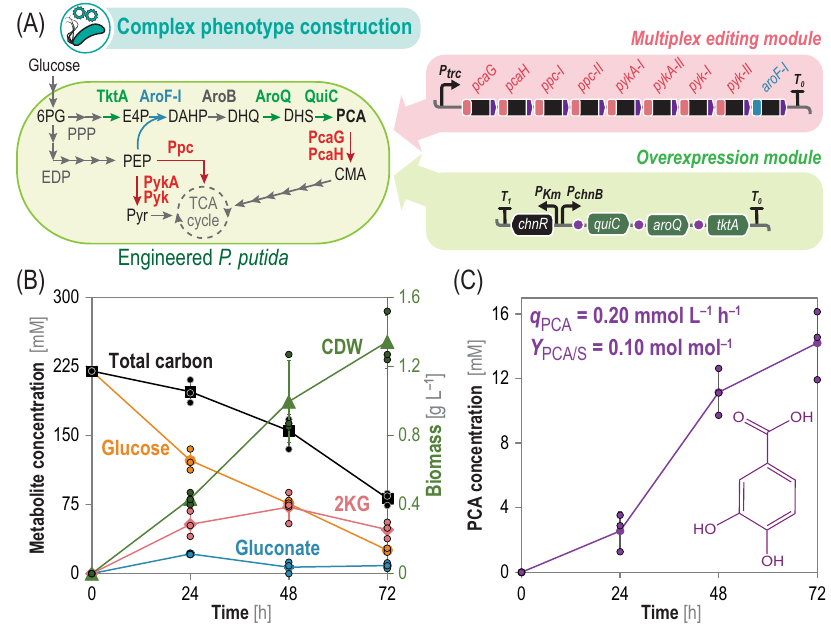
Fig. 5 One-step engineering of P . putida for glucose-dependent production of PCA. A Simpli fi ed metabolic map indicating key reactions eliminated or modi fi ed towards protocatechuate ( PCA ) overproduction. Editing pcaG ( PP_4655 ), pcaH ( PP_4656 ), ppc ( PP_1505 ), pykA ( PP_1362 ), and pyk ( PP_4301 ) blocked the cognate biochemical reactions, while aroF-I ( PP_2324 ) was modi fi ed to remove feedback inhibition on phospho-2-dehydro-3-deoxyheptonate aldolase. All of these modi fi cations are encoded in a single, multiplex editing module, containing nine gRNAs. Additionally, quiC , aroQ and tktA were overexpressed as a synthetic operon under ChnR/ P chnB transcriptional regulation. Genetic elements not drawn to scale. 6PG , 6-phosphogluconate; PEP , phosphoenolpyruvate; Pyr , pyruvate; E4P , erythrose 4-phosphate; DAHP , 3-deoxy-D-arabinoheptulosonate 7-phosphate; DHQ , 3-dehydroquinate; DHS , 3- dehydroshikimate; CMA , β -carboxy- cis , cis -muconate; EDP , Entner-Doudoroff pathway; PPP , pentose phosphate pathway; TCA cycle , tricarboxylic acid cycle. B Growth and substrate consumption and C product formation in shaken- fl ask fermentations of the edited strain. CDW ; cell dry weight; 2KG , 2- ketogluconate; q PCA , PCA volumetric productivity; Y PCA/S , PCA yield on substrate. Data represent mean values ± standard deviation of three independent biological experiments. Source data underlying panels B , C are provided as a Source Data fi